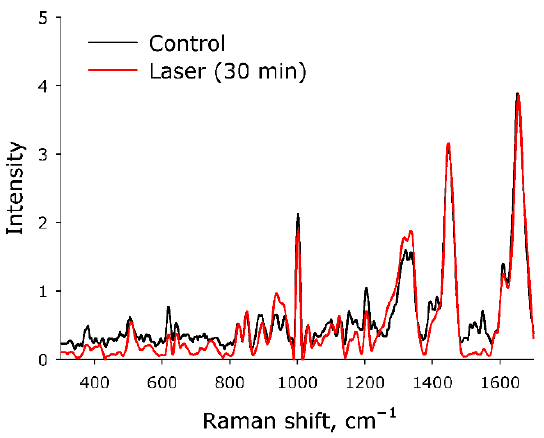
Figure 6. Raman spectra of BSA solutions for control and after 30 min laser exposure. The data were obtained with a Raman microscope. The intensity along the y-axis is presented in relative units.